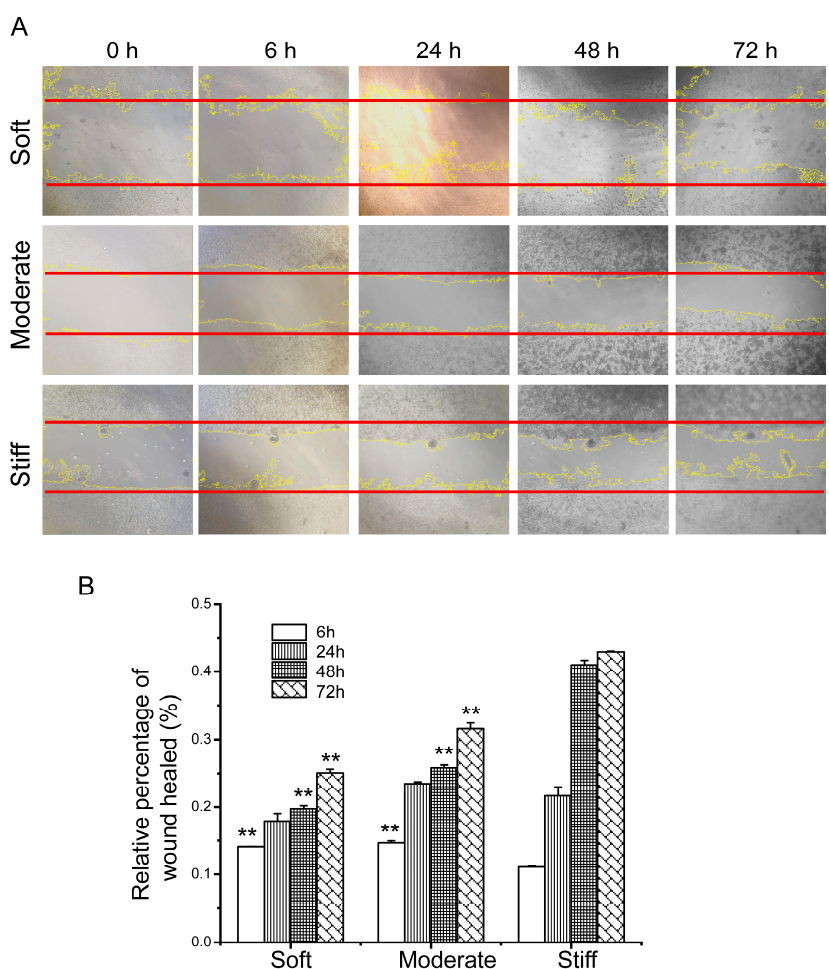
Figure 3. Substrate sti ff ness a ff ects cell migration of confluent hepatocytes. ( A ) Representative scratch assay images of hepatocytes on soft, moderate, and sti ff substrates at di ff erent time points at 40 × objective. ( B ) Relative percentage of the wound healed. The red line represents the initial scratch distance, and the yellow line is the cell boundary line when ImageJ automatically analyzes the scratches. Soft and moderate groups compared to the sti ff group. Data presented as the mean ± SEM ( n = 3). * represents p < 0.05; ** represents p < 0.01.